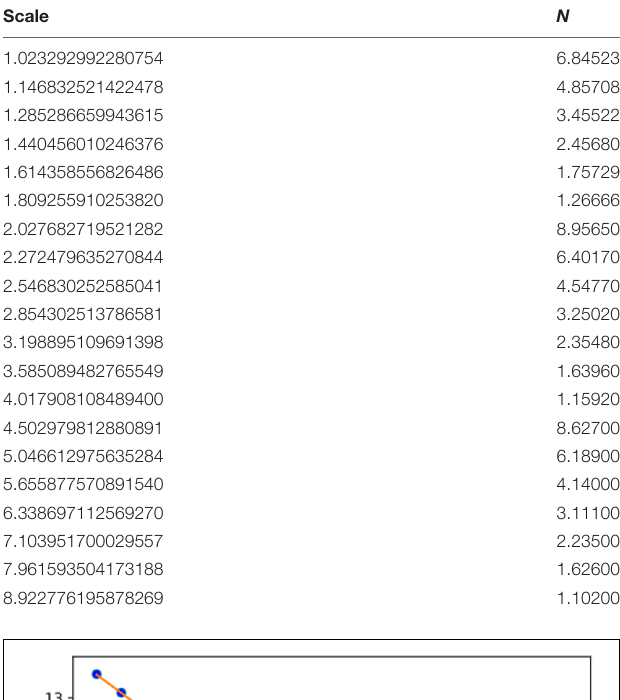
TABLE 2 | The iteration steps to calculate the box-counting FD for the whole volume of session OAS30001_MR_d0129. Scale